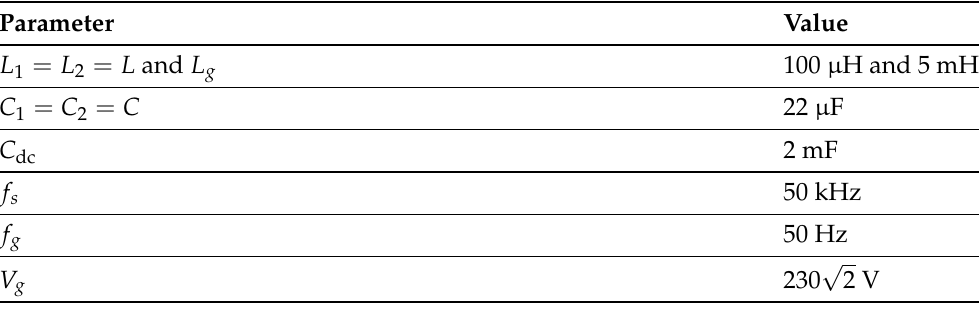
Table 1. Parameter values for the power stage circuit.